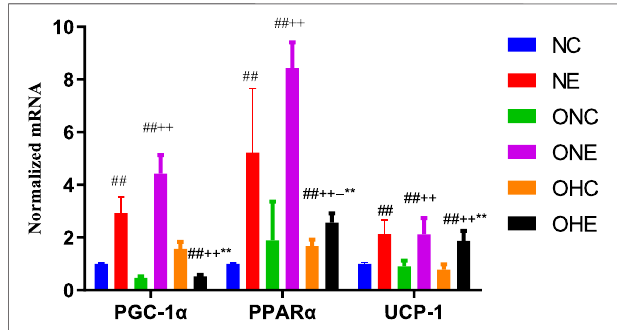
FIGURE 2 | mRNA expression levels of PGC-1 α , PPAR α , and UCP-1 in inguinal fat of rats. mRNA expression levels of PPAR α and UCP-1 in inguinal adipose of rats of NC, NE, ONC, ONE, OHC, and OHE groups were determined using β -Actin as a reference gene. n = 8, # p < 0.05 vs. NC group; ## p < 0.01 vs. NC group; + p < 0.05 vs. ONC group; ++ p < 0.01 vs. ONCgroup;- p < 0.05vs.ONEgroup;-- p < 0.01vs.ONEgroup;* p < 0.05vs. OHC group; ** p < 0.01 vs. OHC group; following tables